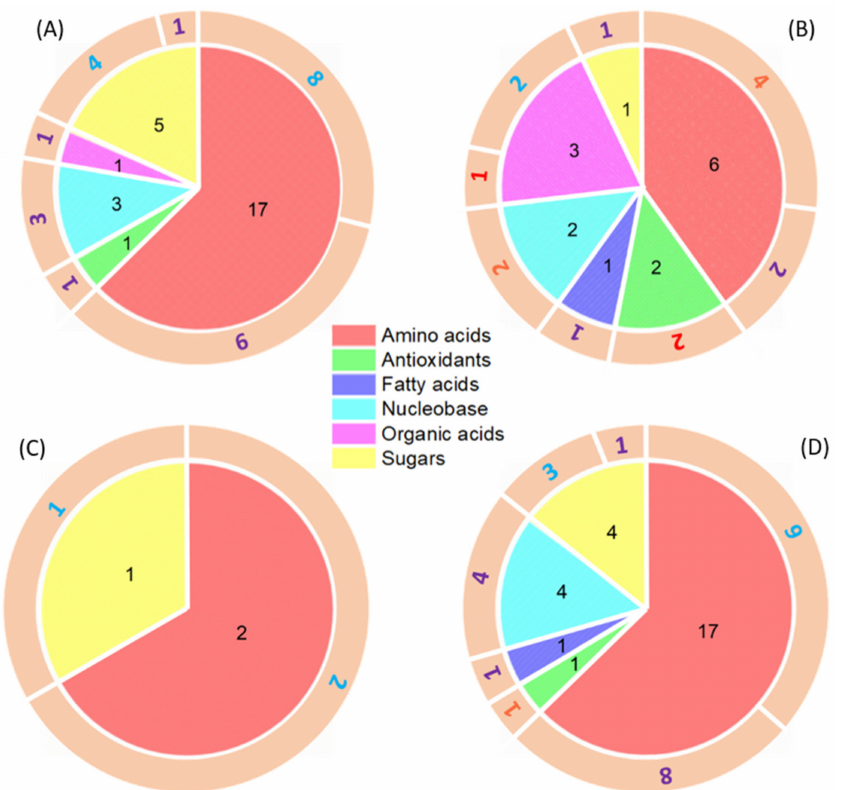
Figure 4. Comparison of significantly changed metabolites (/log2(fold change)/>1) in wheat roots exposed to ( A ) Cu(OH) 2 NMs; ( B ) MoO 3 NMs; ( C ) Cu IONs; and ( D ) Mo IONs. Experimental conditions: SA—200 mg/L Triton TM X-100 solution; Cu(OH) 2 NMs—100 mg/L Cu(OH) 2 NMs (as Cu content) in SA; Cu IONs—0.1 mg/L CuSO 4 · 5H 2 O (as Cu content) in SA; MoO 3 NMs— 100 mg/L MoO 3 NMs (as Mo content) in SA; and Mo IONs—35 mg/L Na 2 MoO 4 · 2H 2 O (as Mo content) in SA. The numbers in the pie chart represent the significantly changed metabolites from each metabolite category. The color of the numbers in the outer circular ring indicates fold changes of the significantly dysregulated metabolites: red (fold change > 5), orange (2 < fold change < 5), blue (0.2 < fold change < 0.5), and purple (fold change < 0.2). Three replicates under each